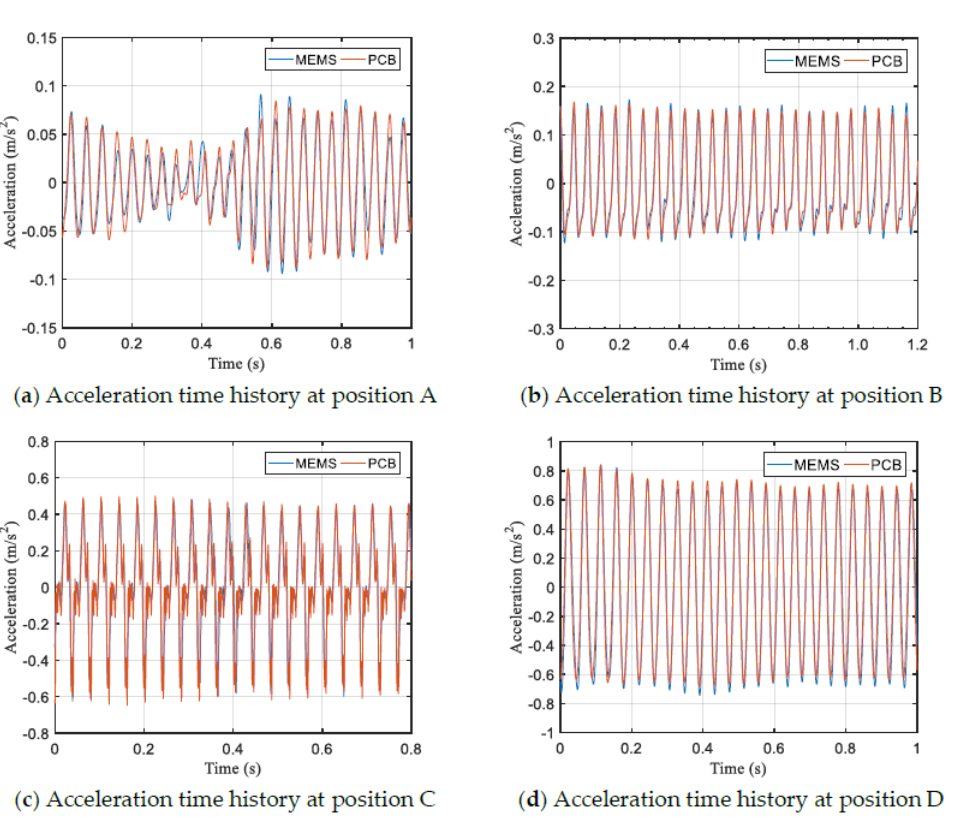
Figure 16. Measured acceleration time histories at di ff erent locations.